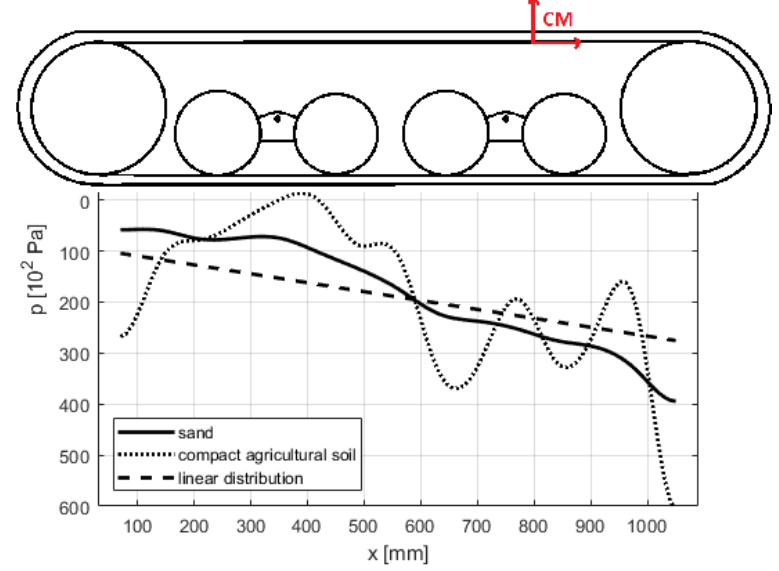
Figure 16. Pressure distribution for the track-terrain